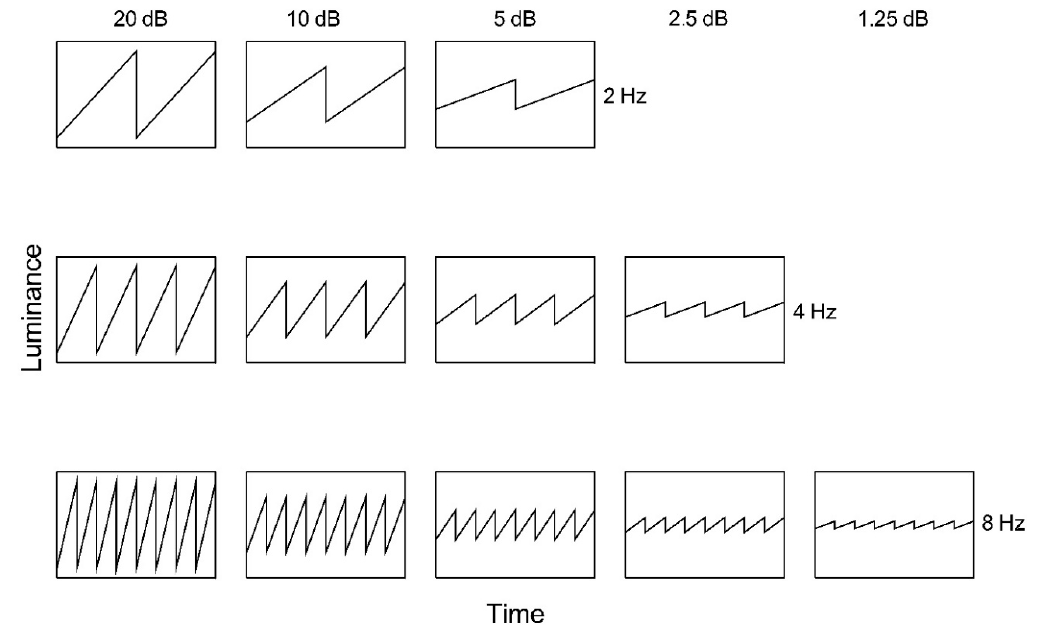
Figure 2. Ascending sawtooth luminance waveforms as a function of time. Nominal amplitude is indicated above each column and temporal frequency to the right of each row.